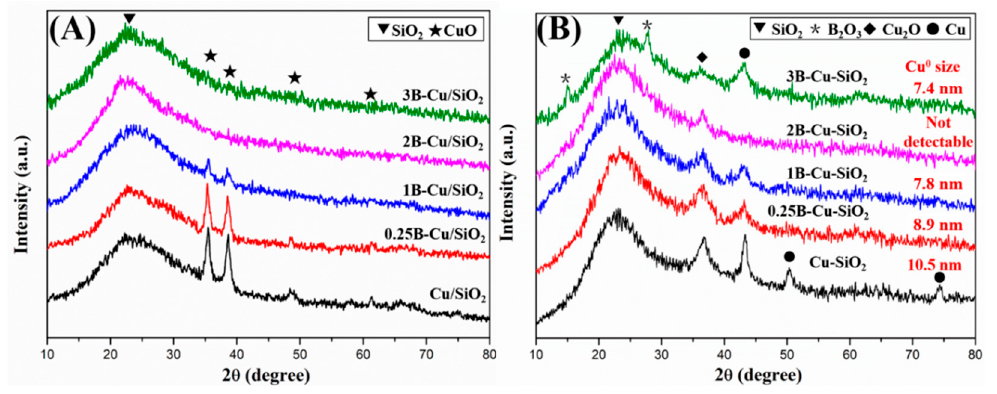
Figure 1. XRD patterns of the calcined ( A ) and reduced ( B ) x B-Cu/SiO 2 catalysts. To further observe the surface morphology of the catalysts, the reduced Cu/SiO 2 and 2B-Cu/SiO 2 catalysts were characterized by TEM images, and the relevant results were shown in Figure 2. It was notable that the Cu particles on the surface of Cu/SiO 2 catalyst were relatively large and agglomerate to a certain extent. The mean size of Cu particles of the Cu/SiO 2 catalyst was about 8.4 nm based on the statistical results of TEM images. However, after adding an appropriate amount of boron promoter, the metallic Cu particles of the 2B-Cu/SiO 2 catalyst were more uniformly dispersed without obvious agglomeration, and the average diameter was about 5.1 nm. Moreover, the enlarged TEM image and the EDS data in Figure S3 indicated that the Cu and B species were homogeneously evenly dispersed on the silica texture, overlapping with each other, implying that there was a strong interaction between active component Cu and boron promoter. The reason might be that Cu and B species were in close proximity, hindering the conversion of Cu 2+ to Cu 0 to a certain extent. The results of TEM images further proved that boron promoter could promote the D Cu of the Cu/SiO 2 catalysts by restraining the increase of Cu particles size, which were consistent with the conclusions of N 2 -adsorption, XRD and H 2